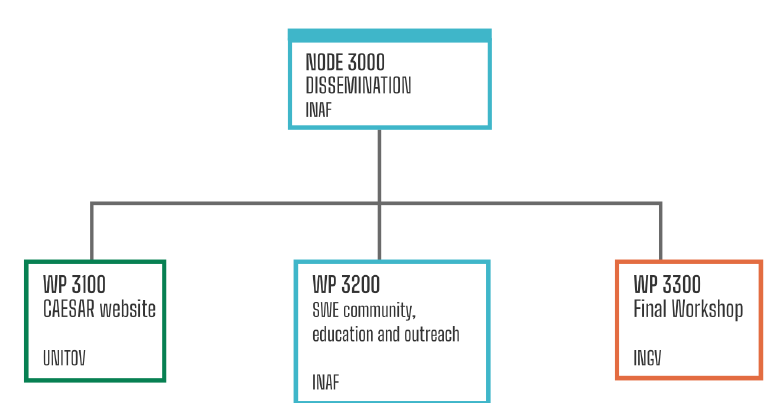
Figure 4. Work breakdown structure of NODE 3000. Colors indicate institutions described in the legend of Figure